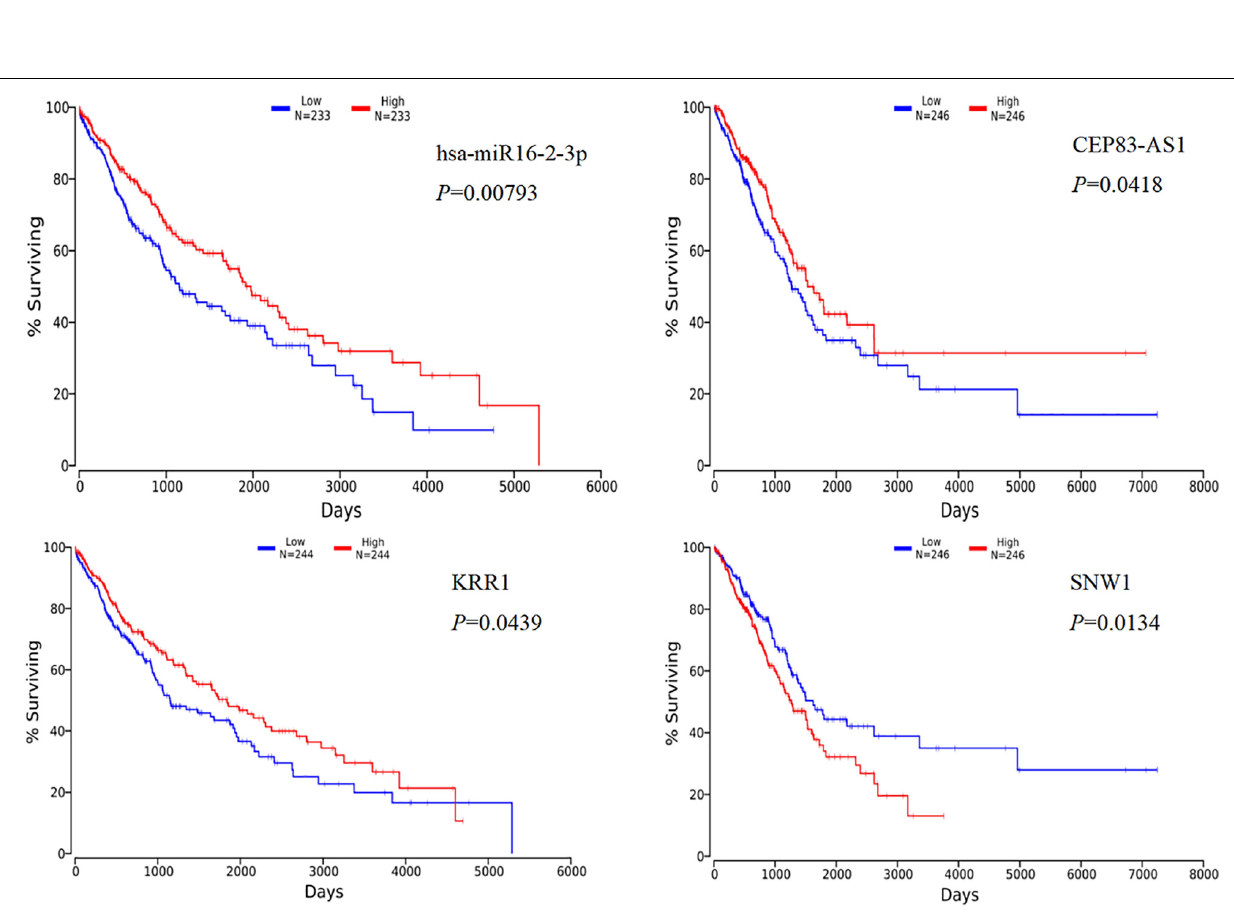
Frontiers in Genetics |